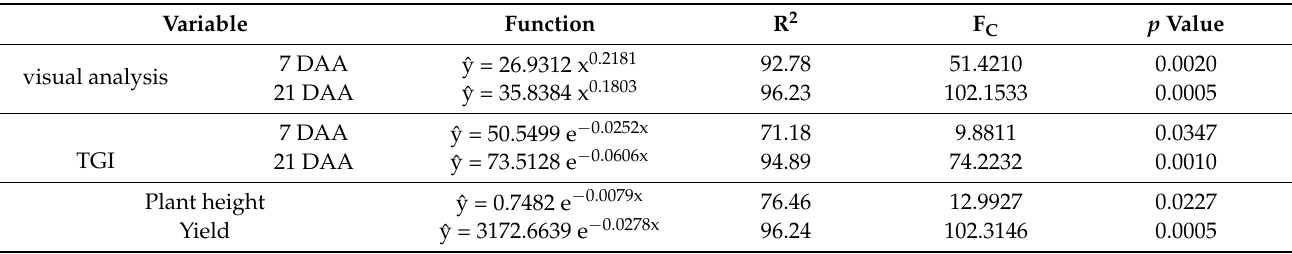
Nonlinear regression models were adjusted for the effects of dicamba doses on all variables and assessment periods (Table 2). The visual analysis (7 and 21 DAA) fitted in a model of power regression, while TGI (7 and 21 DAA), plant height, and yield fitted in a model of exponential regression. The best model adjustments (R 2 > 90.0) were obtained for visual analysis (7 and 21 DAA), TGI (21 DAA), and yield. Table 2. Models of regression adjustments of visual analysis of soybean leaf injury, TGI vegetation index, plant height, and crop yield (ˆy) as a function of dicamba dose (x).